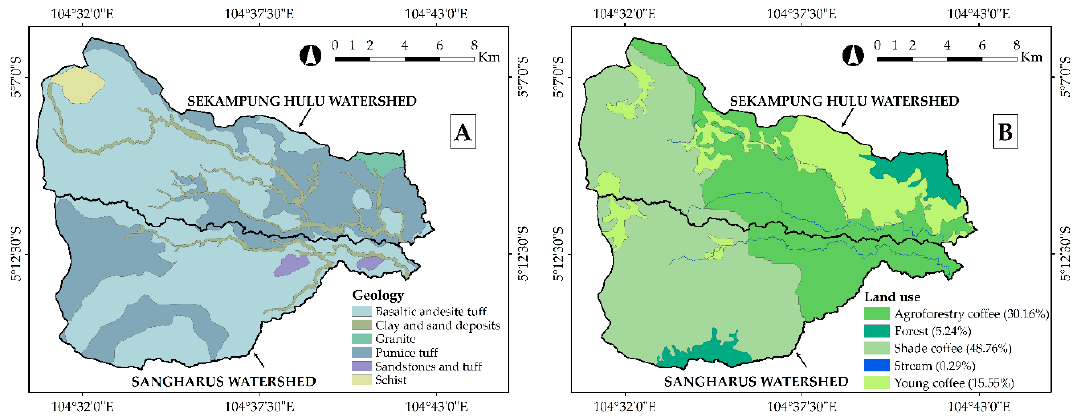
Figure 1. Map of study area showing the location of the Sekampung Hulu and Sangharus watersheds in Indonesia. The sampling locations are highlighted by the green circles.